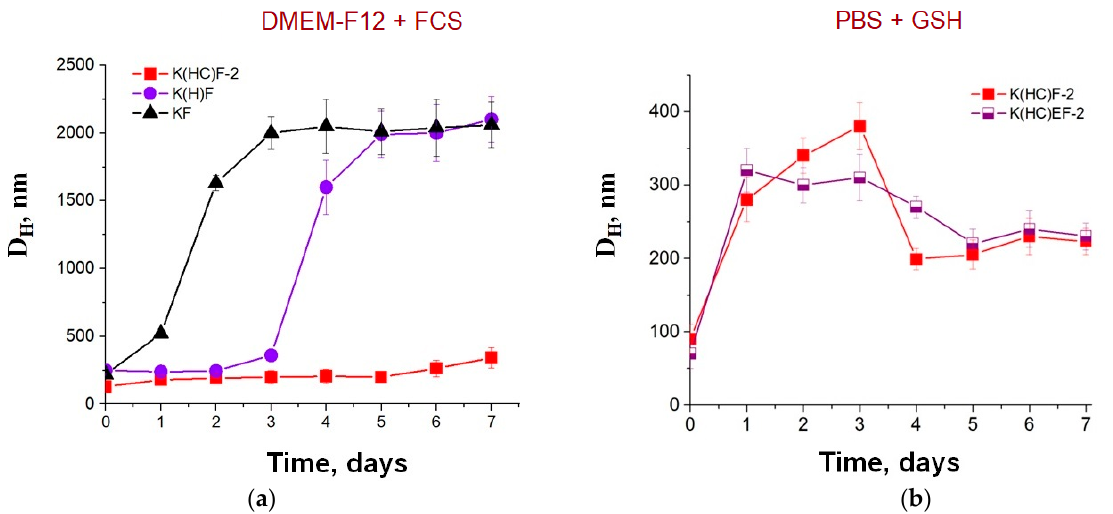
Figure 4. Stability of different nanoparticles incubated at 37 °C (monitoring by DLS) in cell culture medium containing proteins (DMEM-F12 + FCS) ( a ) and cross-linked nanoparticles in the 0.01 M phosphate buffer saline (PBS) solution containing glutathione (GSH, 10 mM) ( b ).